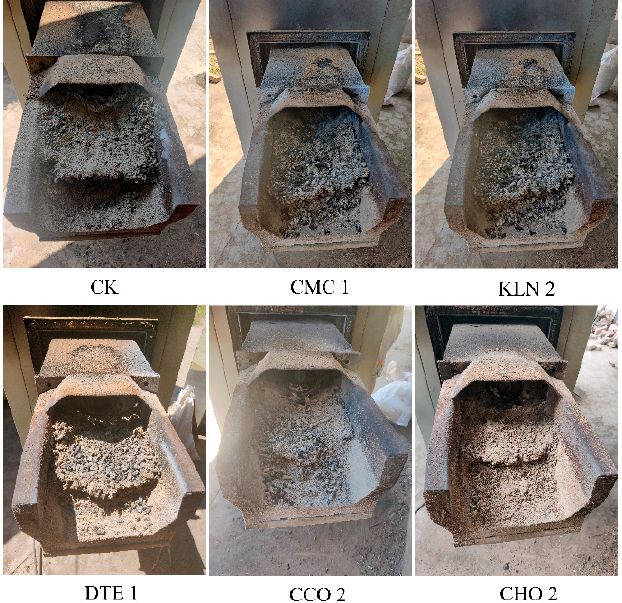
Figure 2. Comparison of furnace slagging under natural ventilation: calcium carbonate (CCO), calcium dihydrogen phosphate (CHO), carboxymethyl cellulose (CMC), control (CK), diatomaceous earth (DTE) and kaolin (KLN).